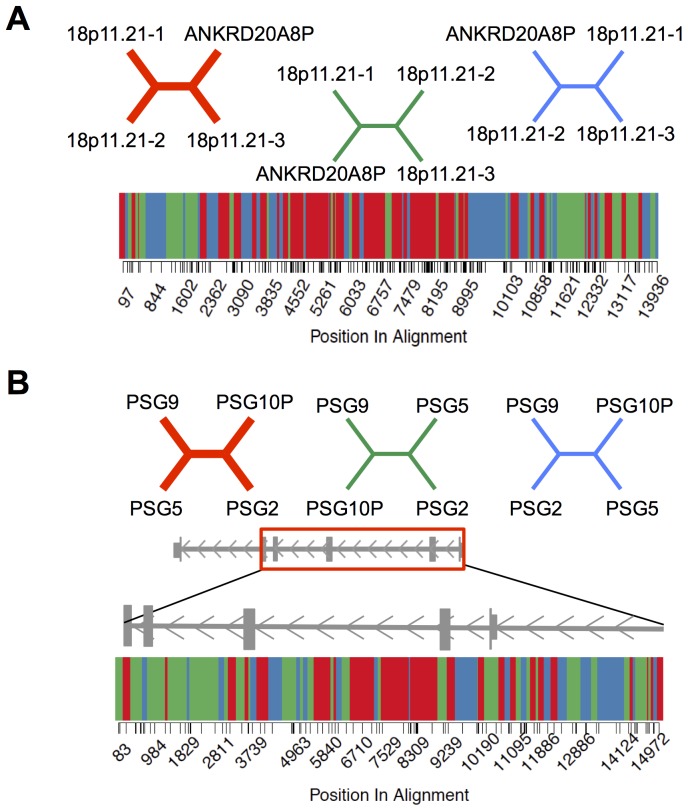
Site-to-site variation in phylogenetic history across SD alignments.(A) Variation in tree topology across an alignment of ANKRD20A8P and 3 paralogous sequences in the 18p11.21 region. The dominant topology is depicted in red, with the two alternative unrooted topologies shown in green and blue. Informative positions within the CpG negative alignment are denoted by tick marks along the x-axis. Variation in tree topology across the alignment is shown, with colors corresponding to the 3 possible topologies. The midpoint between adjacent informative sites was used to estimate positions where the tree shifts to a new topology. (B) Variation in tree topology across an alignment of 4 genes in the PSG family. The PSG gene model is shown, with the region corresponding to the aligned region boxed in red.